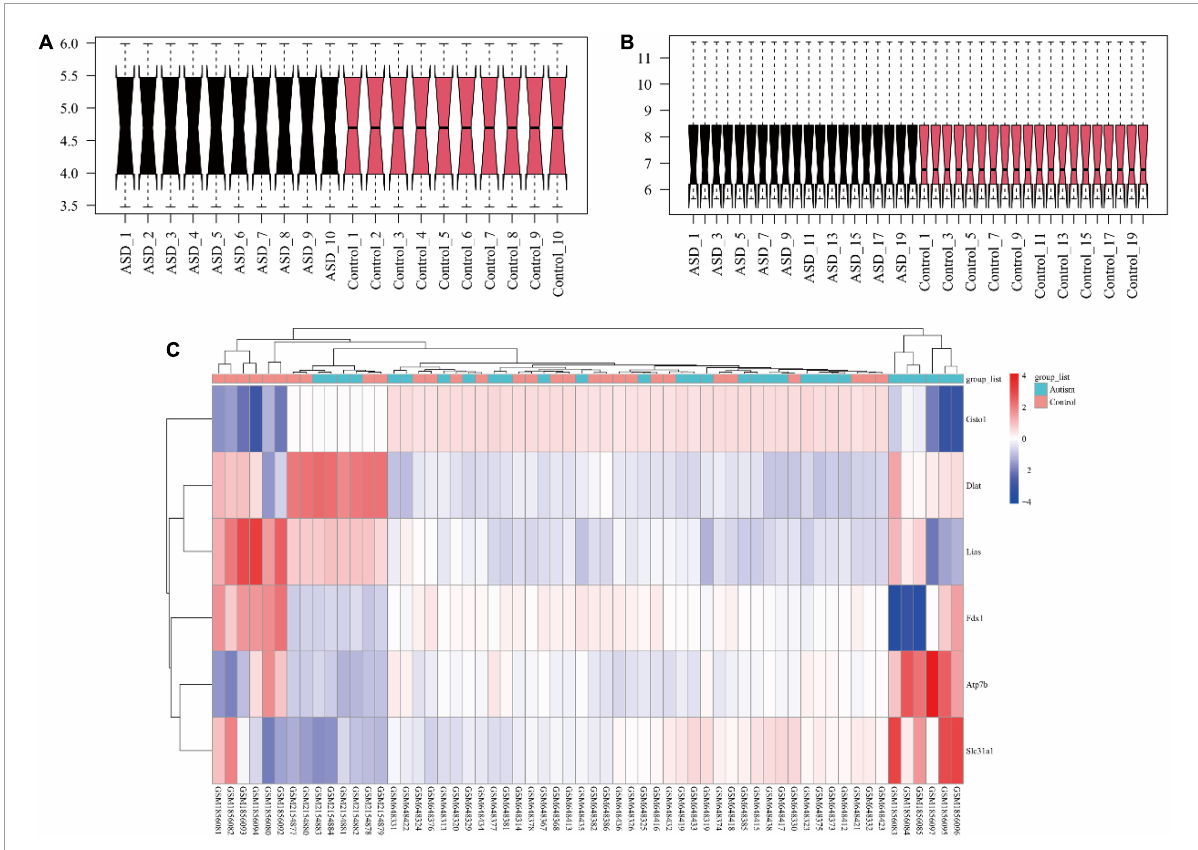
FIGURE2 The visualization of gene expression profiles. The gene expression data were normalized between arrays of mouse brain (A) and human blood (B) . The crucial genes in the cuproptosis signaling pathway and the selected arrays of each dataset were visualized in a heatmap (C) . ASD, autism spectrum